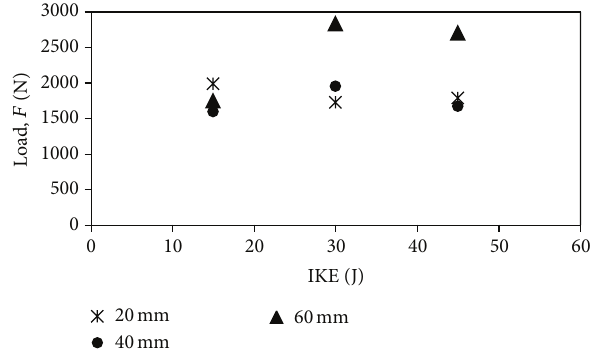
Figure 10: Maximum load recorded on the sandwich beams subjected to three IKE